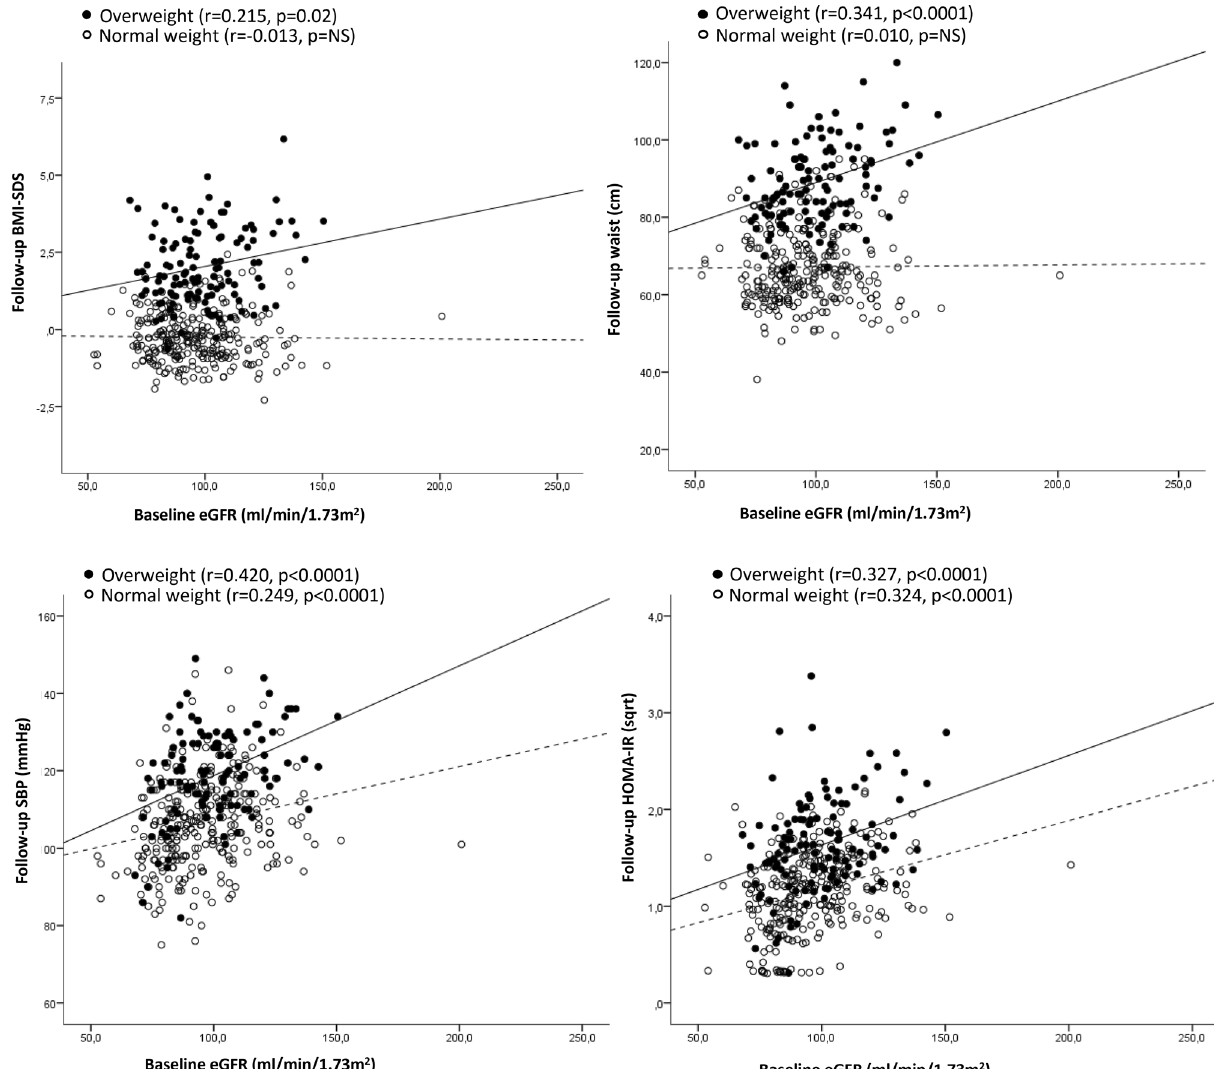
Figure 1. Correlation graphs of eGFR at baseline with selected variables at follow-up (n = 401). White dots and dotted line depict children with normal weight (BMI-SDS < 1) and black dots and solid line, children with overweight (BMI-SDS ≥